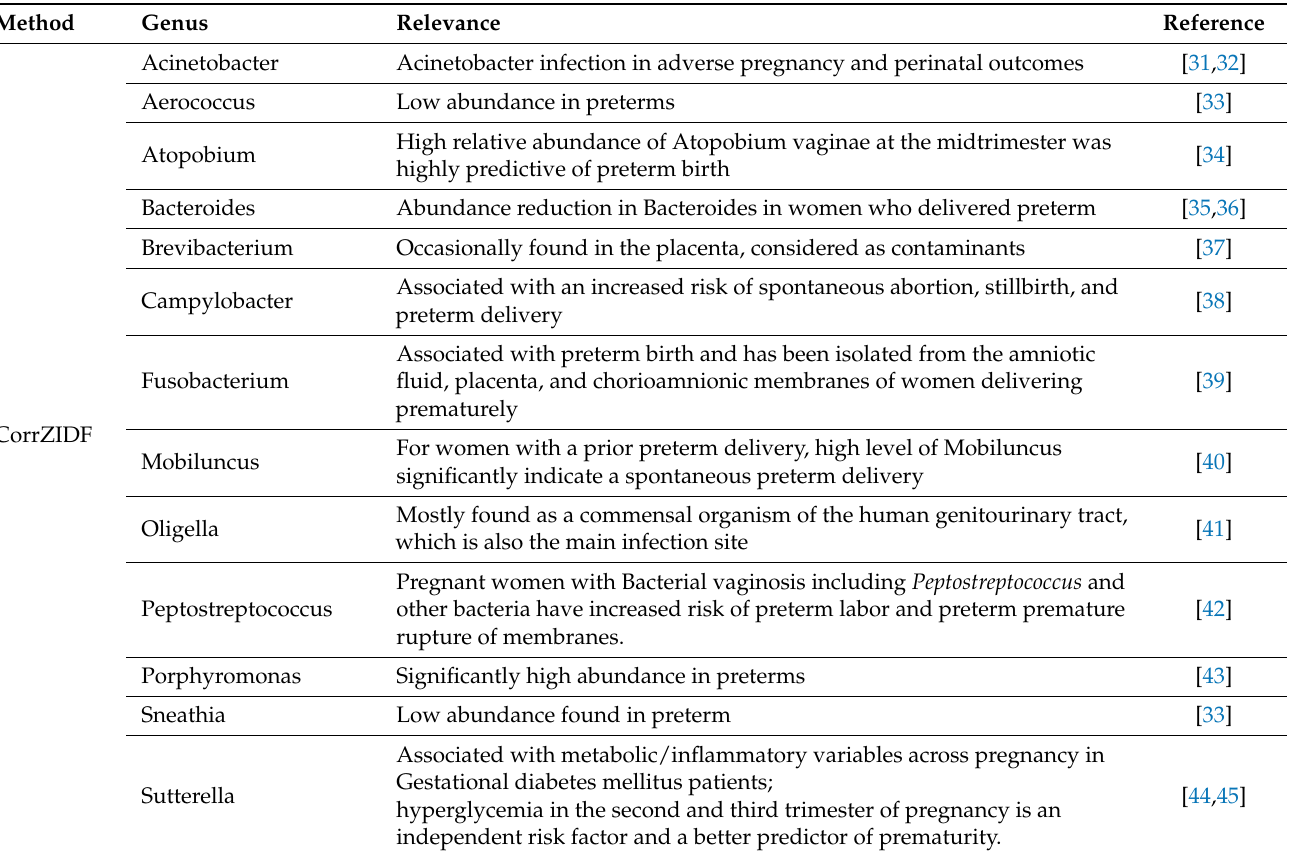
Figure 4. A Venn diagram of the distribution of the significantly differentiated results by the CorrZIDF, ZIDF and FZINBMM for a pregnancy dataset. Table 2. List of unique genera by each method for the pregnancy data.